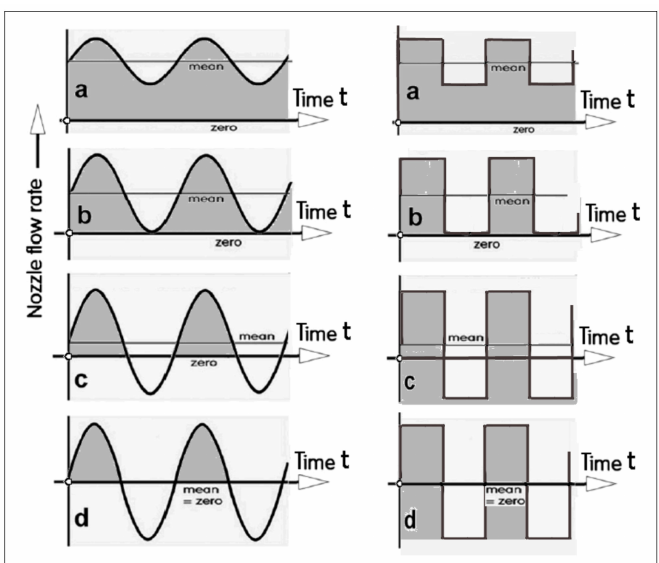
Figure 1. Fluid flows with periodicity. Left column: time dependence of harmonic oscillations. Right column: ideal rectangular pulses. Cases are named: ( a ) small modulation depth, ( b ) fully pulsed flow, ( c ) amplitude of oscillating component larger than mean flow, and ( d ) alternating